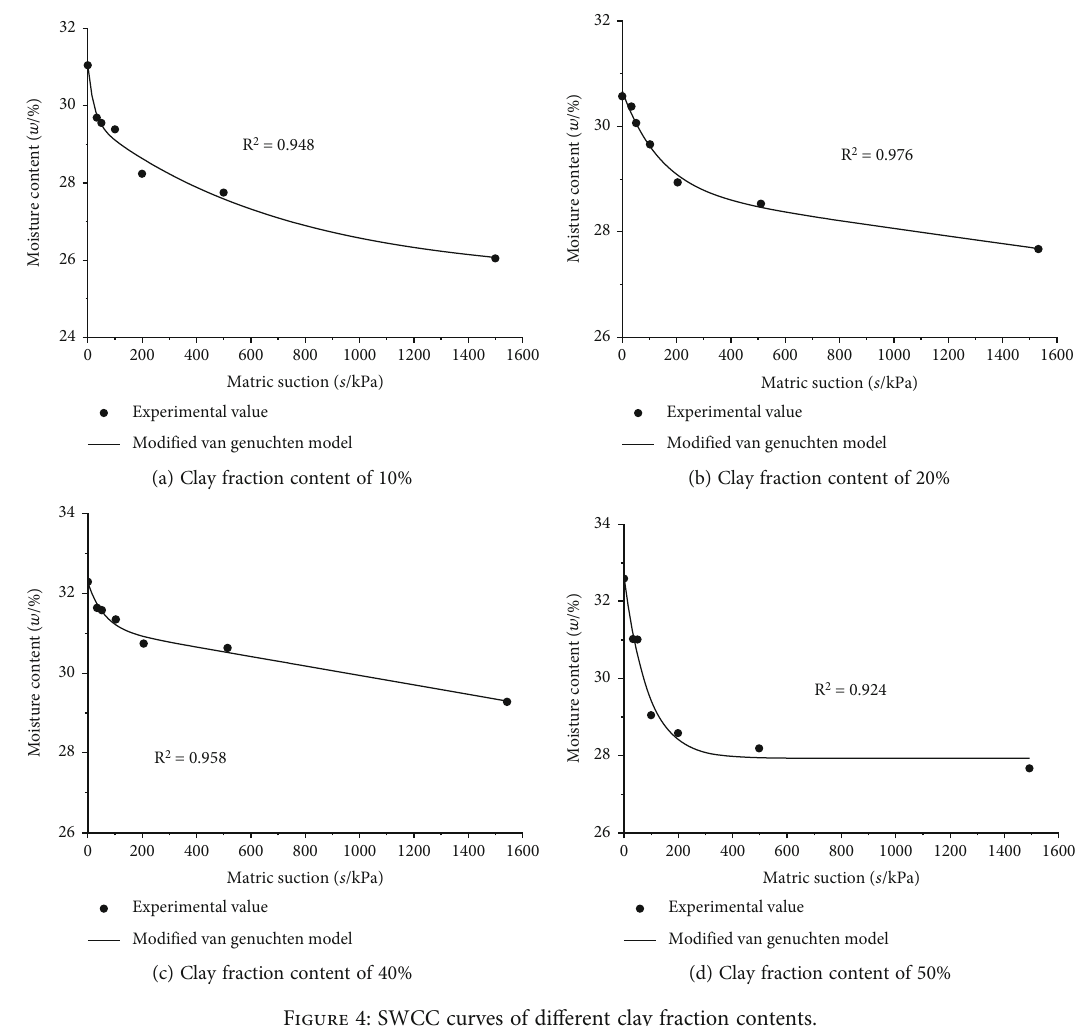
Figure 4: SWCC curves of di ff erent clay fraction contents.